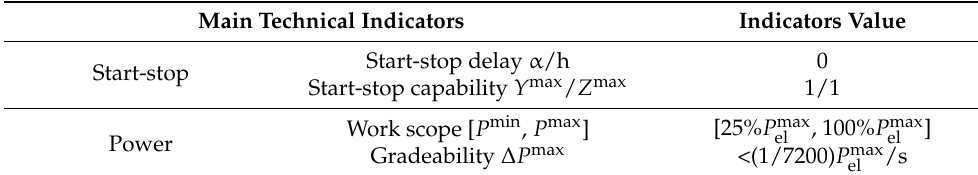
Table 1. Main technical indexes of an alkaline electrolytic